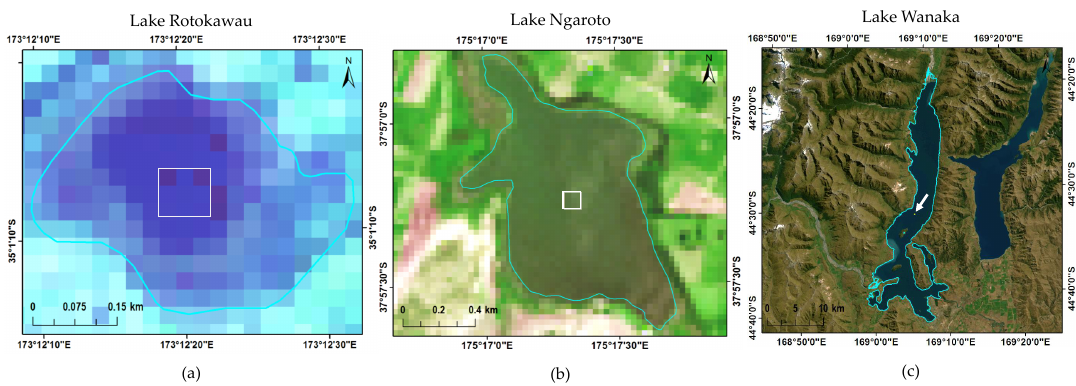
Figure 3. Landsat 8 Operational Land Imager (OLI) images of three example lakes showing the 3-by-3 pixel area for which data was extracted. The outlines shown were taken from the FENZ geodatabase. North is up in all images. ( a ) Lake Rotokawau (volcanic lake) on 3 March 2017; ( b ) Lake Ngaroto (peat lake) on 2 March 2016; and, ( c ) Lake Wanaka (glacial lake) on 3 March